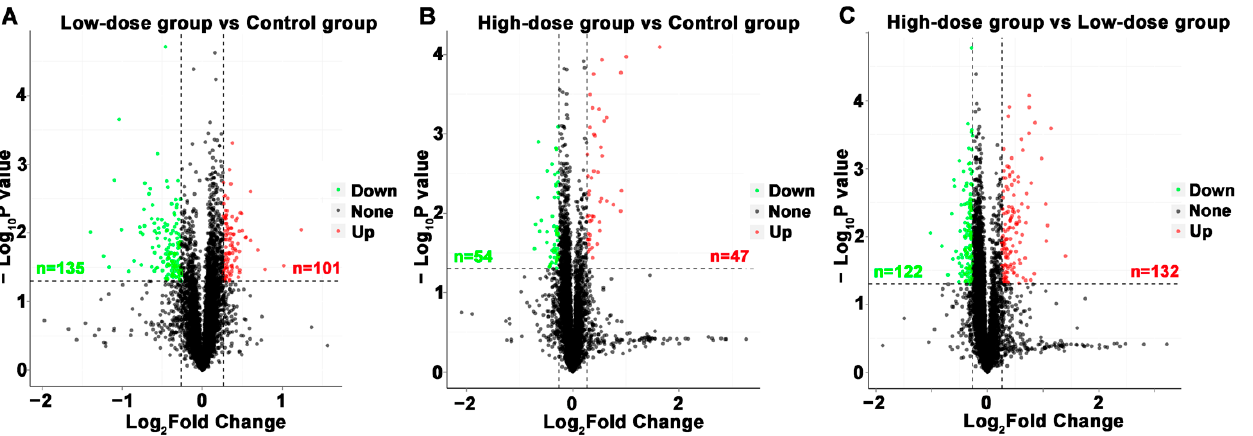
Figure 2. The volcano plots of differentially expressed proteins (DEPs) between different groups. ( A ) low-dose group vs. control group. ( B ) high-dose group vs. control group; ( C ) high-dose vs. low-dose group. Significant difference for the p value on vertical ordinate (Base 10 logarithmic transformation). Red dots represent up-regulated; green dots represent down-regulated; black dots represent no significant difference.